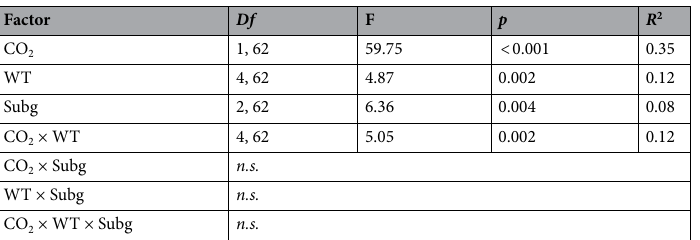
Table 1. Summary of ANOVA results for linear mixed effect models of the effects of atmospheric CO 2 , water table (WT) and Sphagnum subgenus (Subg.) on the D6 S /D6 R ratio. Df , degrees of freedom of the model and residuals. Non-significant factors/interactions with p > 0.1 are denoted as